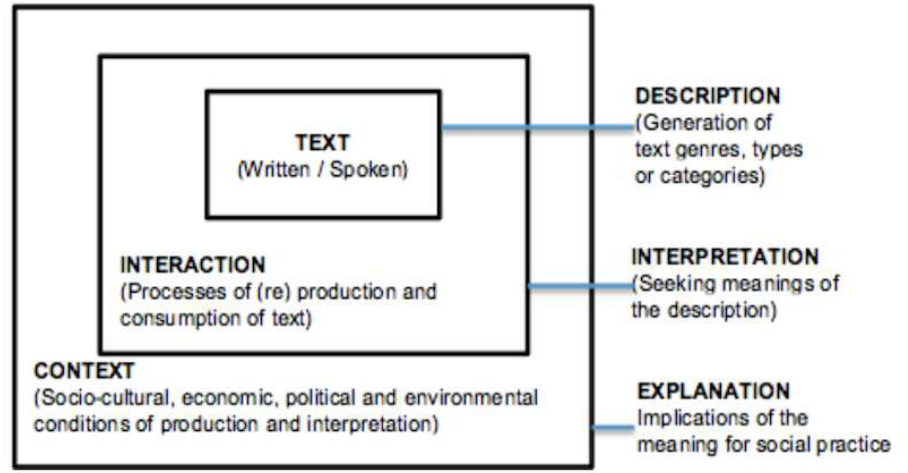
Figure 1. Three dimensional framework proposed by Fairclough (1992)